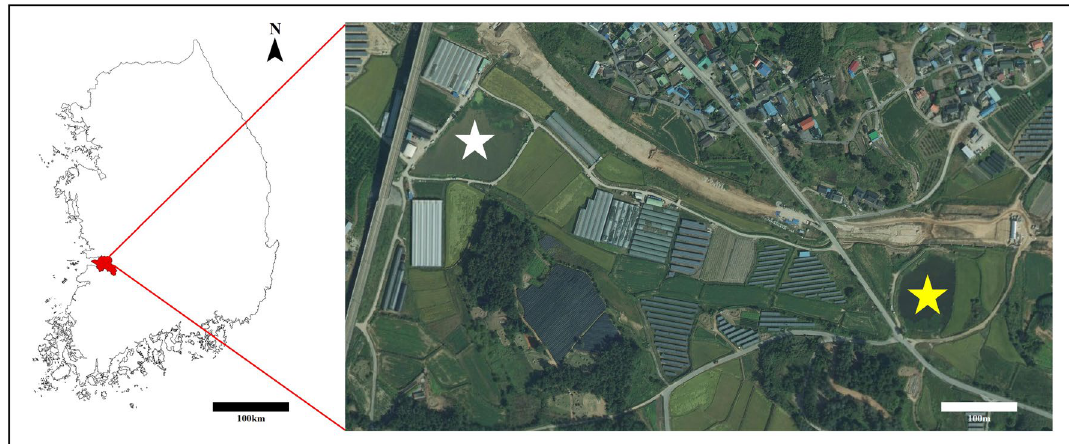
Figure 1. Map of the study area. The study sites are star marked, Deokro Reservoir (the white star), and Sango Reservoir (yellow star). The map was created using ArcMap (ver. 10.7, ESRI; https:// suppo rt. esri. com/ en/ produ cts/ deskt op/ arcgis- deskt op/ arcmap/ 10-7-1) and QGIS Desktop TMS for Korean users Plugin (ver. 1.5; https:// plugi ns. qgis. org/ plugi ns/ tmsfo